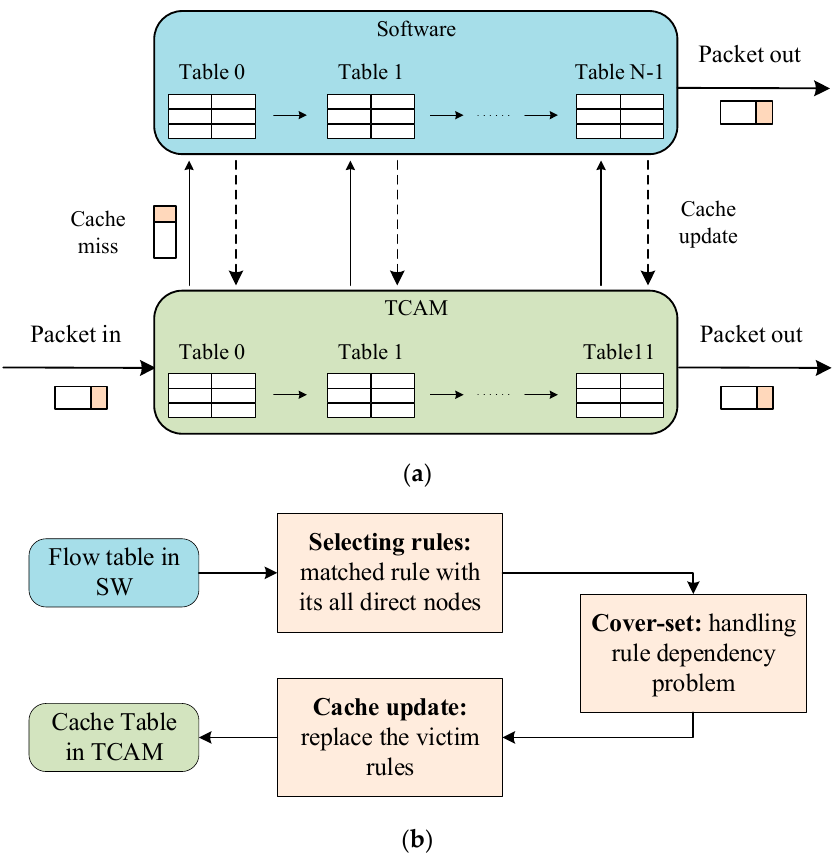
Figure 6. Overview of PipeCache. ( a ) The structure of PipeCache. ( b) Cache update.